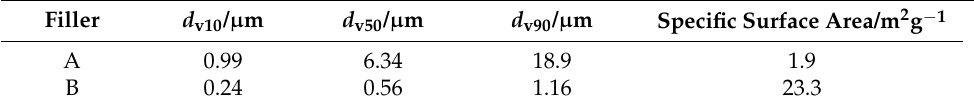
Table 2. Resulting filler particle data after drying